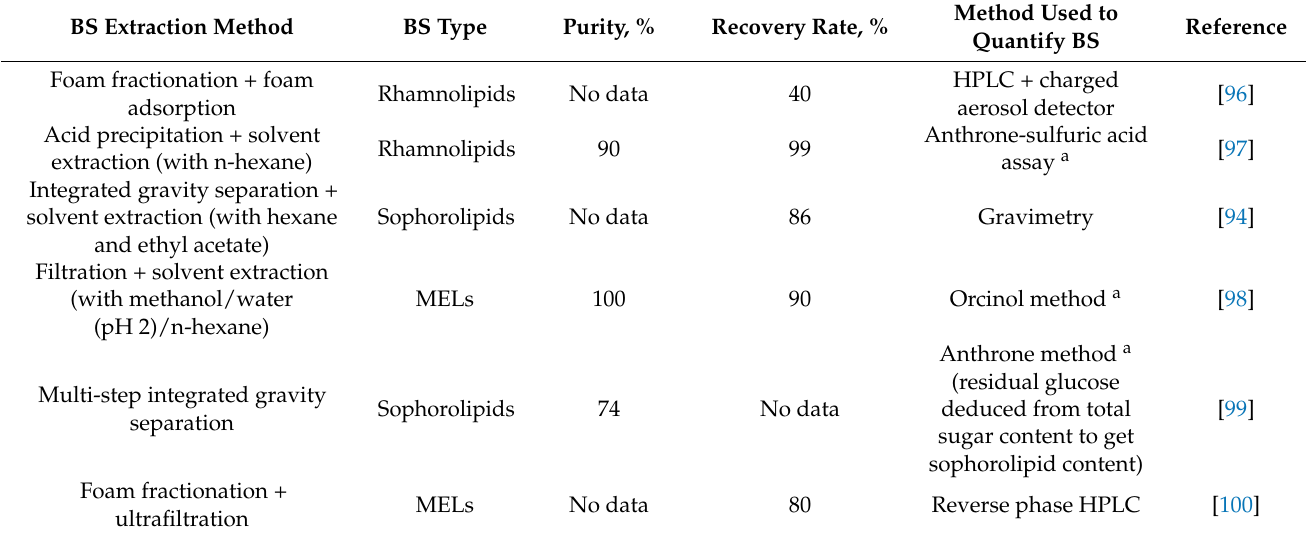
Table 4. The glycolipid purity levels and recovery rates obtained using different BS extractions and purification methods, and the methods used to quantify the glycolipid